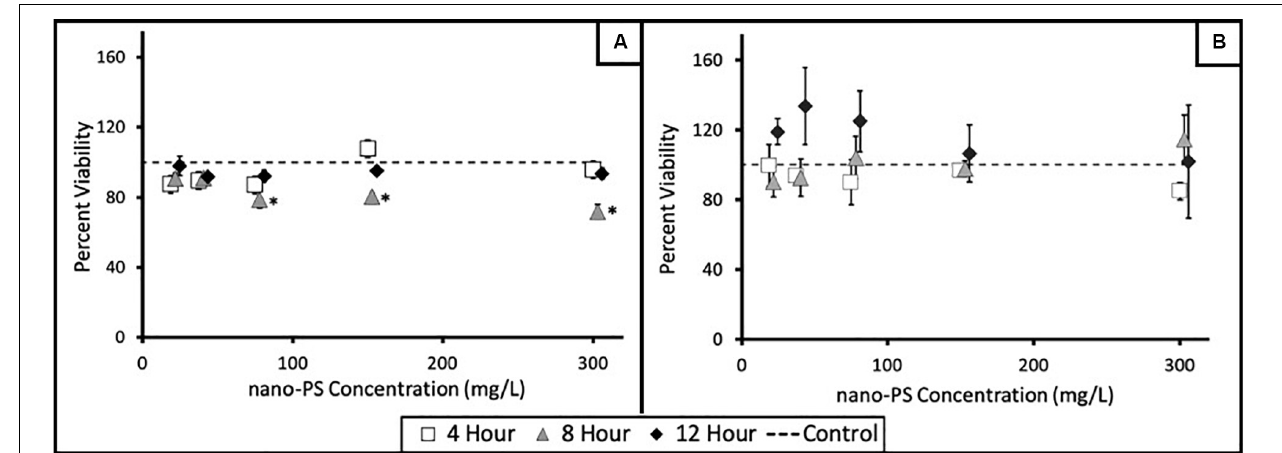
FIGURE 2 | Viability of S. oneidensis exposed to nano-PS as measured with a growth-based viability assay. Cells were exposed to varied concentrations of nano-PS (18.75–300 mg mg/L) for varying exposure lengths (4, 8, 12 h) in (A) aerobic and (B) anaerobic conditions. Markers at each of the nano-PS exposure concentrations are slightly staggered to highlight the viabilities for exposure length. The dashed line represents the control wells, which were normalized to the 100% viable calibration wells (* p < 0.05). Biological triplicates were performed for each exposure condition, where one assay was considered a single biological replicate containing four exposure wells for each nano-PS exposure concentration. Error bars represent the SEM of biological triplicates.